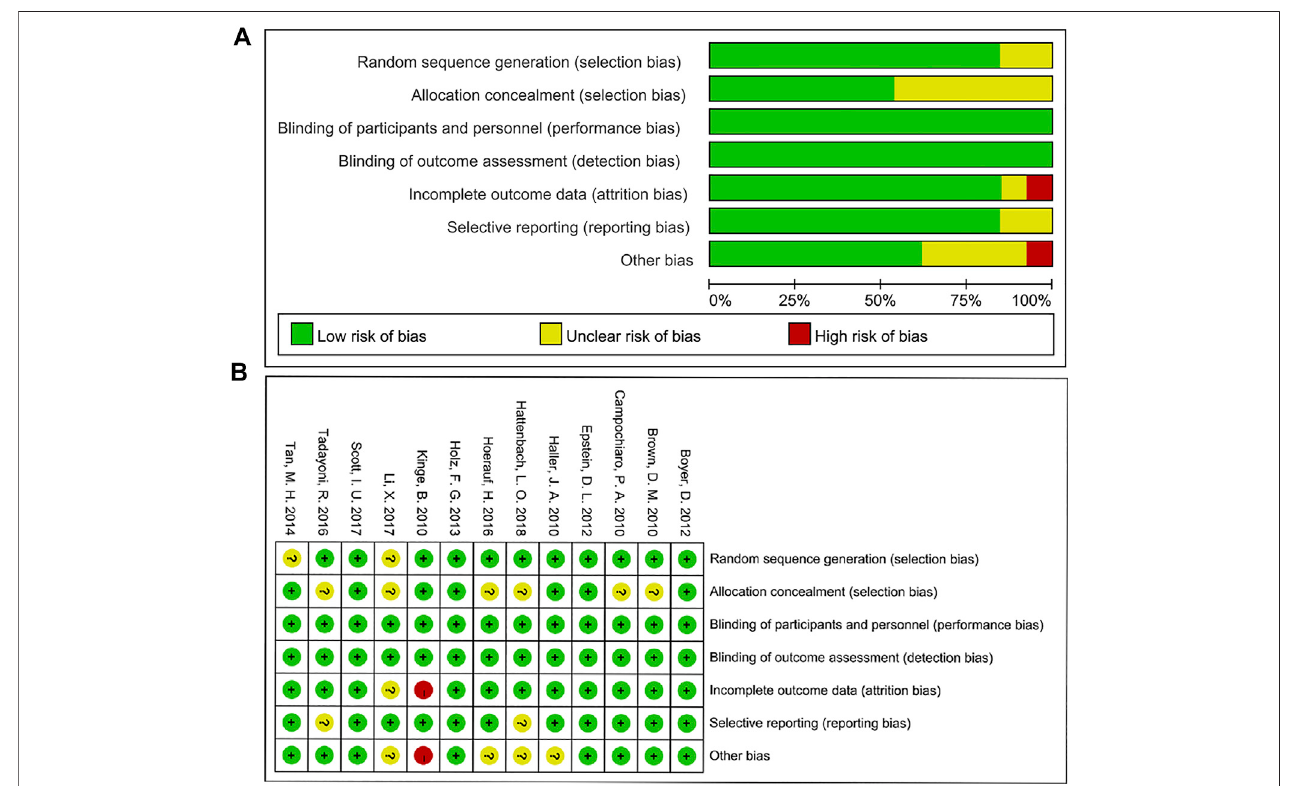
FIGURE 5 | Risk of bias graph (A) and summary (B)